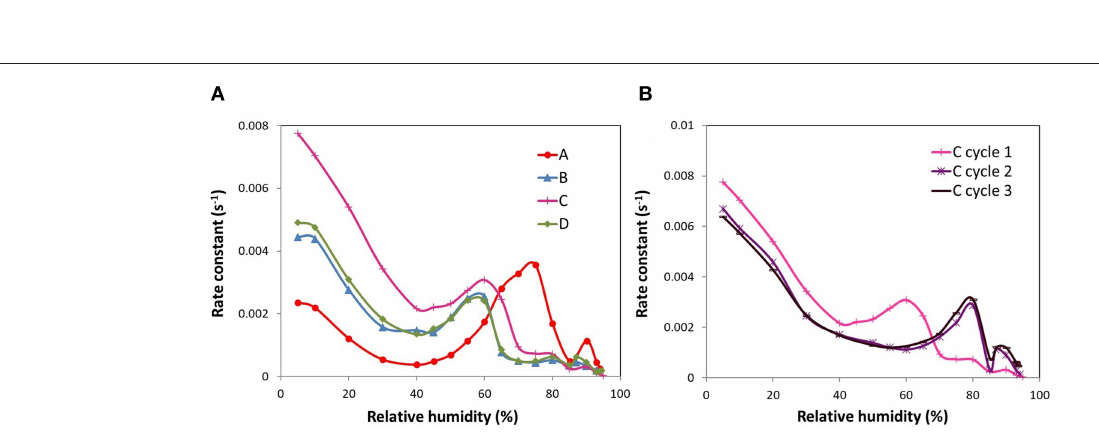
FIGURE 5 | Rate constants of the ACFs as a function of relative humidity: (A) fluorinated ACFs and (B) first to third cycle for ACF